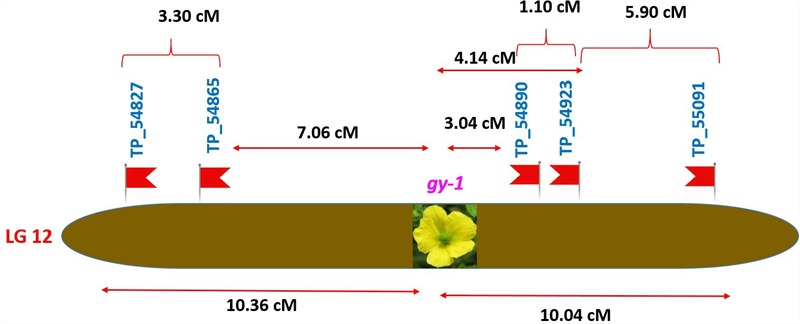
Genetic map of putative gynoecious locus (gy-1) on linkage group-12.